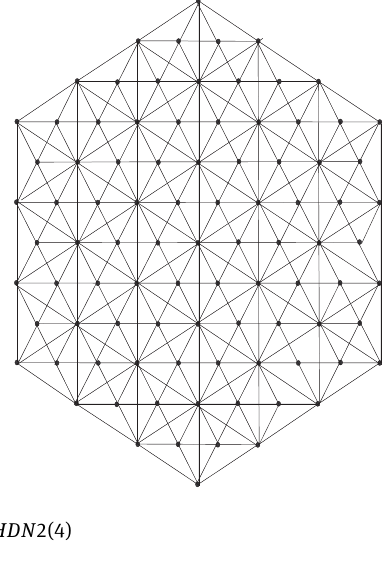
Figure 4: A 4-dimensional hex-derive network HDN 2(4)